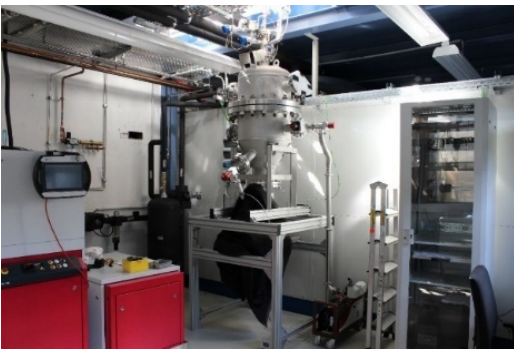
Figure 7. Experimental setup in the laboratory. Figure 7 . Experimental setup in the laboratory.